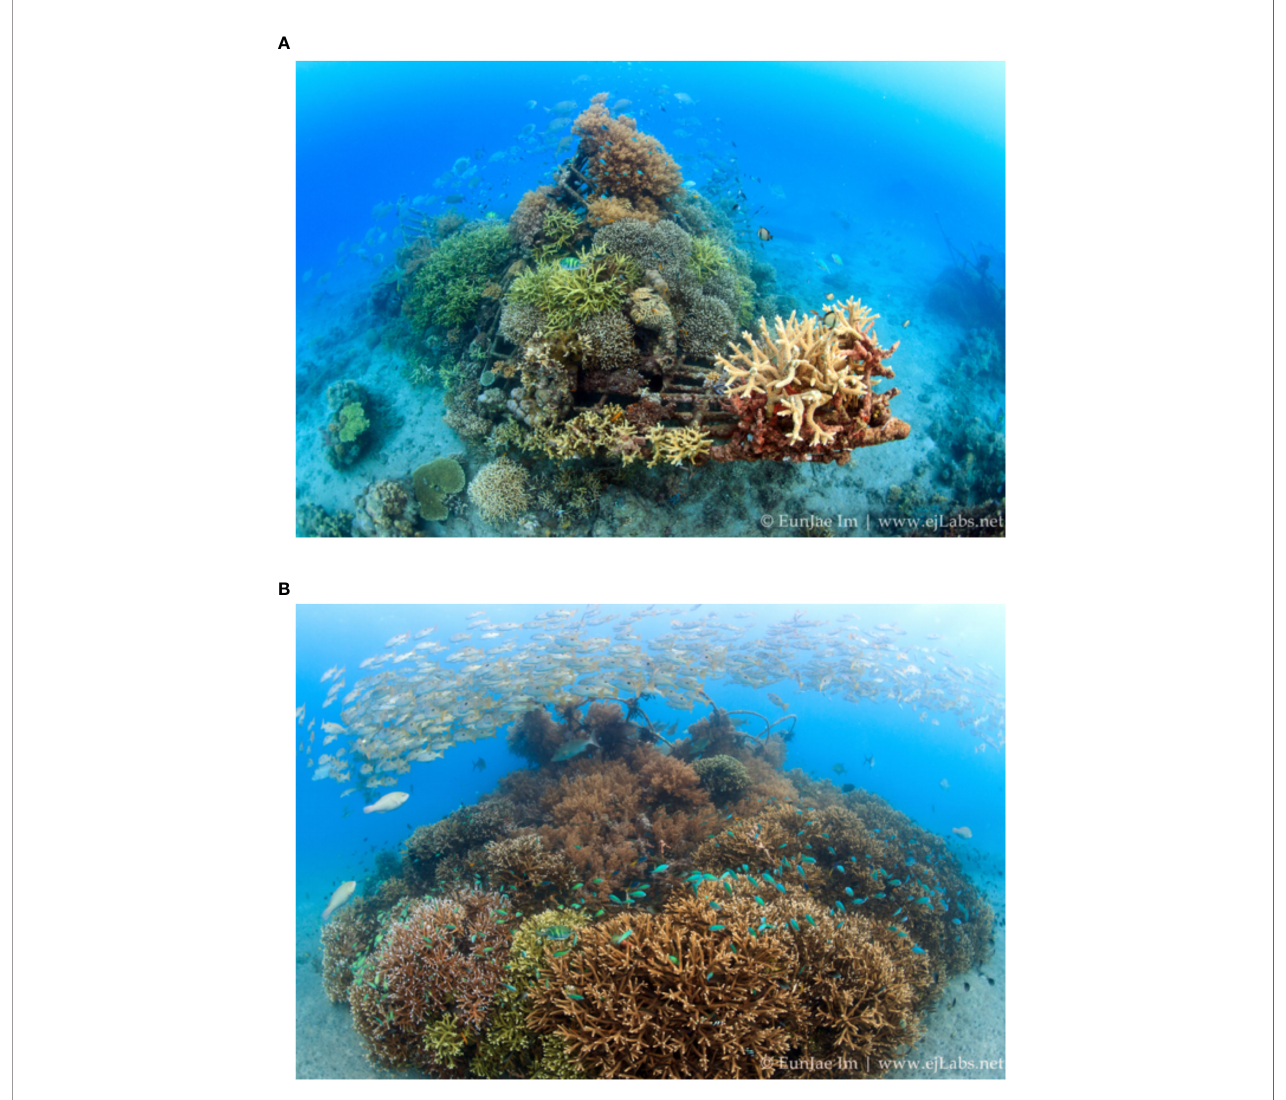
FIGURE 9 | (A) 4 Year old Biorock reef in Pemuteran, Bali. Photograph by Eun Jae Im. (B) High fi sh diversities and densities are found in four year-old Biorock reefs over sand and rubble previously barren of corals and fi shes. Photograph Pemuteran, Bali, by Eun Jae